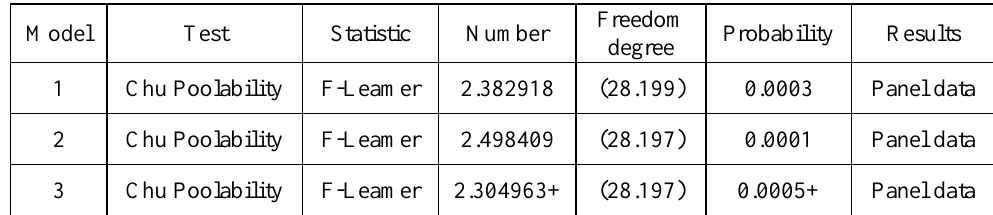
Table 4. Results of F-Limer test